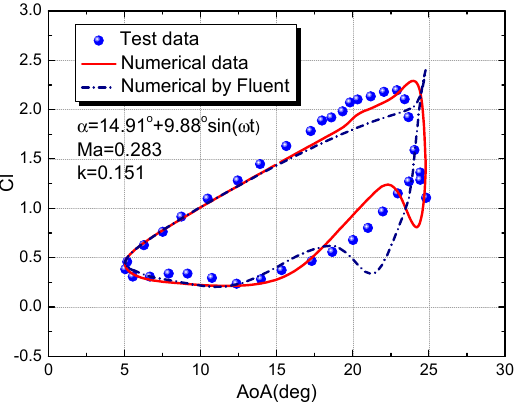
Figure 4. Comparison of simulated C l with test data.